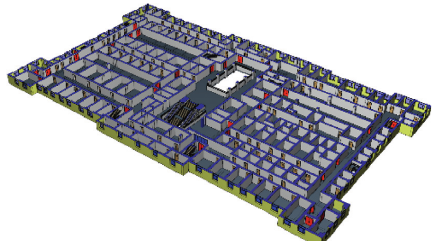
Figure 20: Fire model diagram of floor 5.